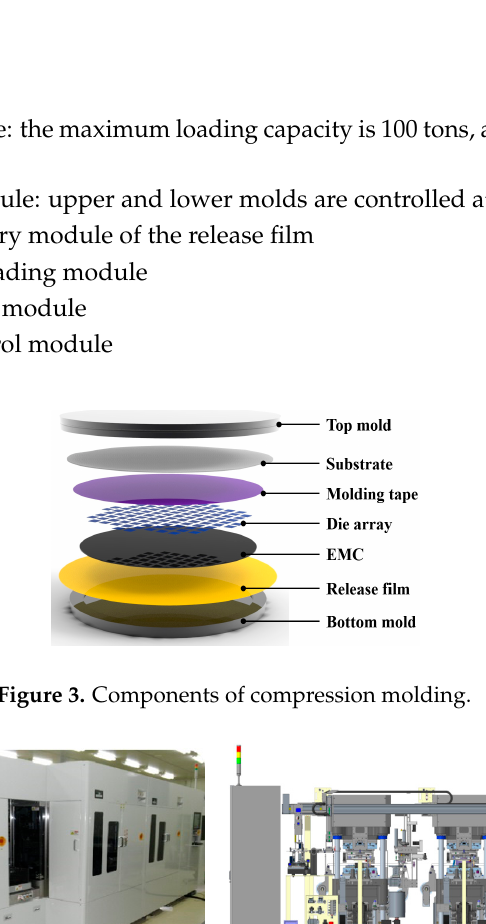
Figure 4. Detailed composition of the compression molding system: ( a ) wafer-level compression molding system; ( b ) system configuration.